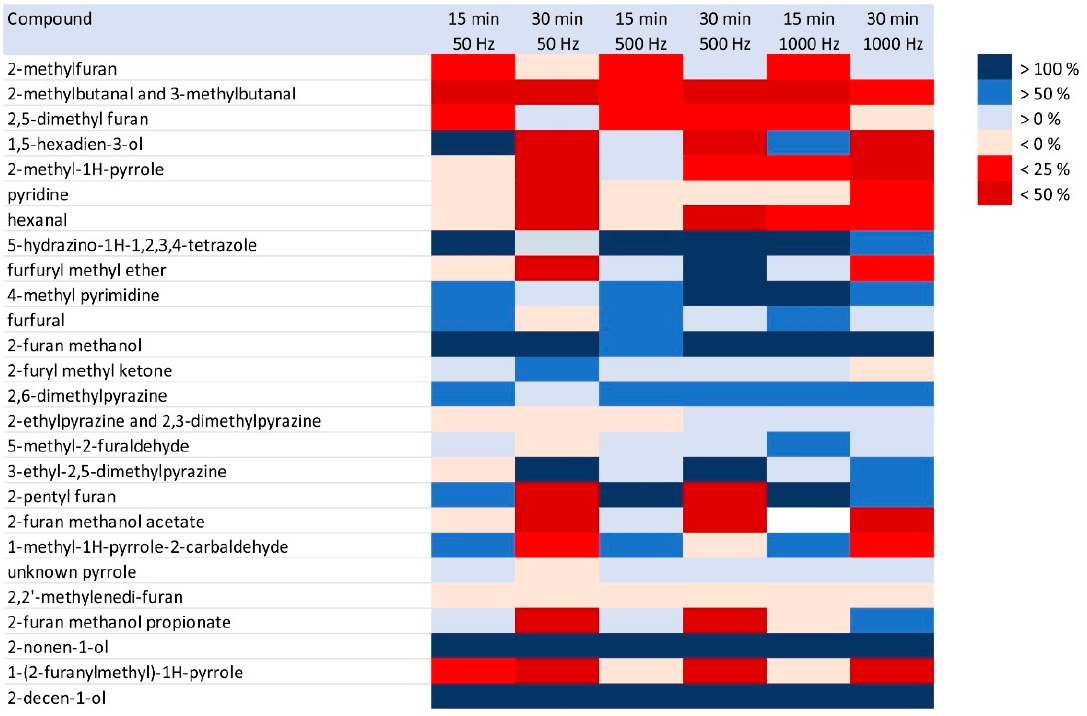
Figure 1. Heat map illustrating the changes in the mass fraction of volatile components compared to the untreated RTD coffee. the untreated RTD